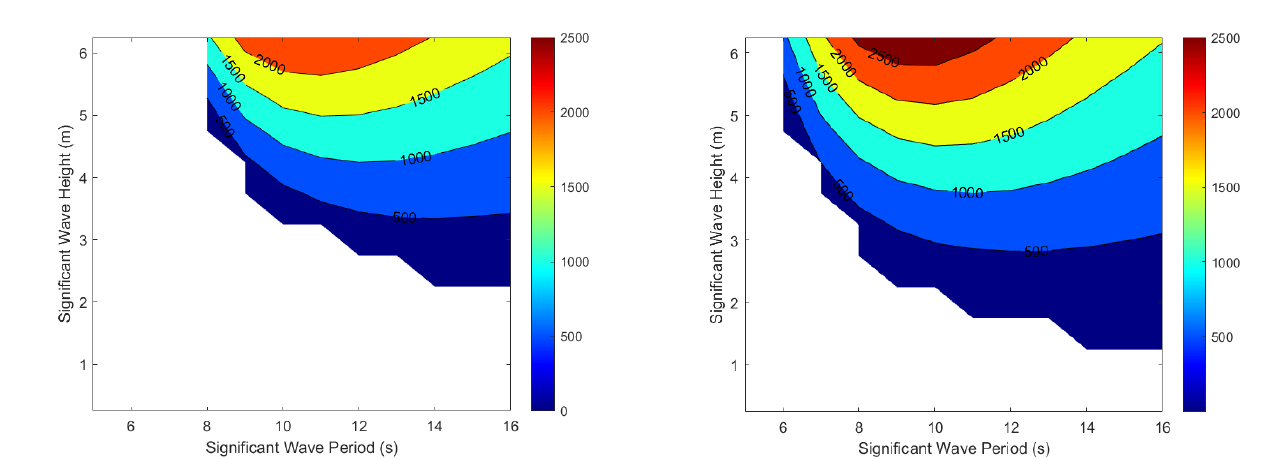
Fig. 14: Estimated shaft power generated per unit span after losses were considered for irregular wave simulations. Left, controller 1. Right, controller 2. Units in